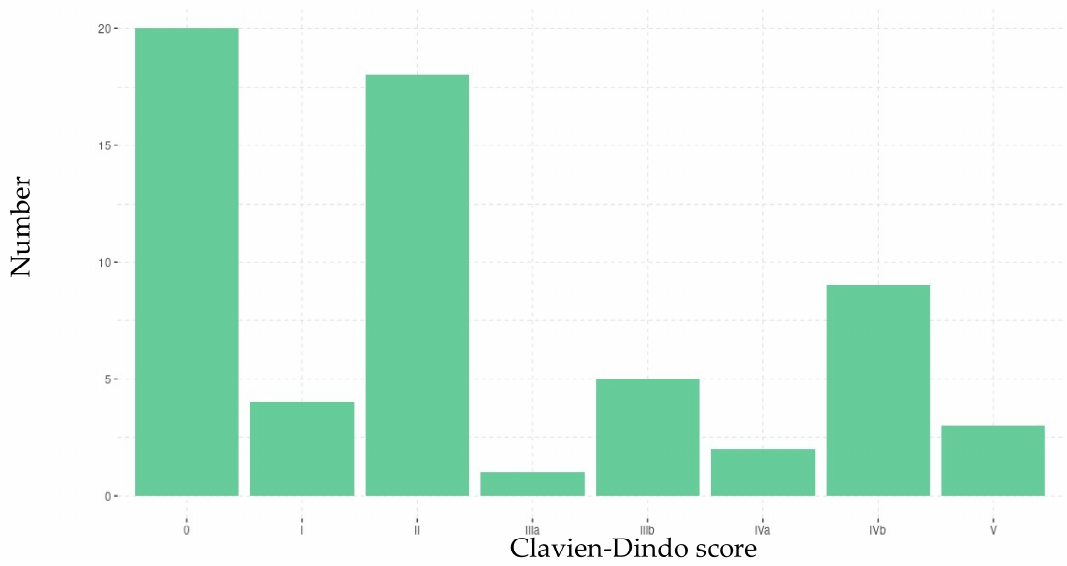
Figure 2. Severity of the patients’ complications, according to the Clavien-Dindo classification.